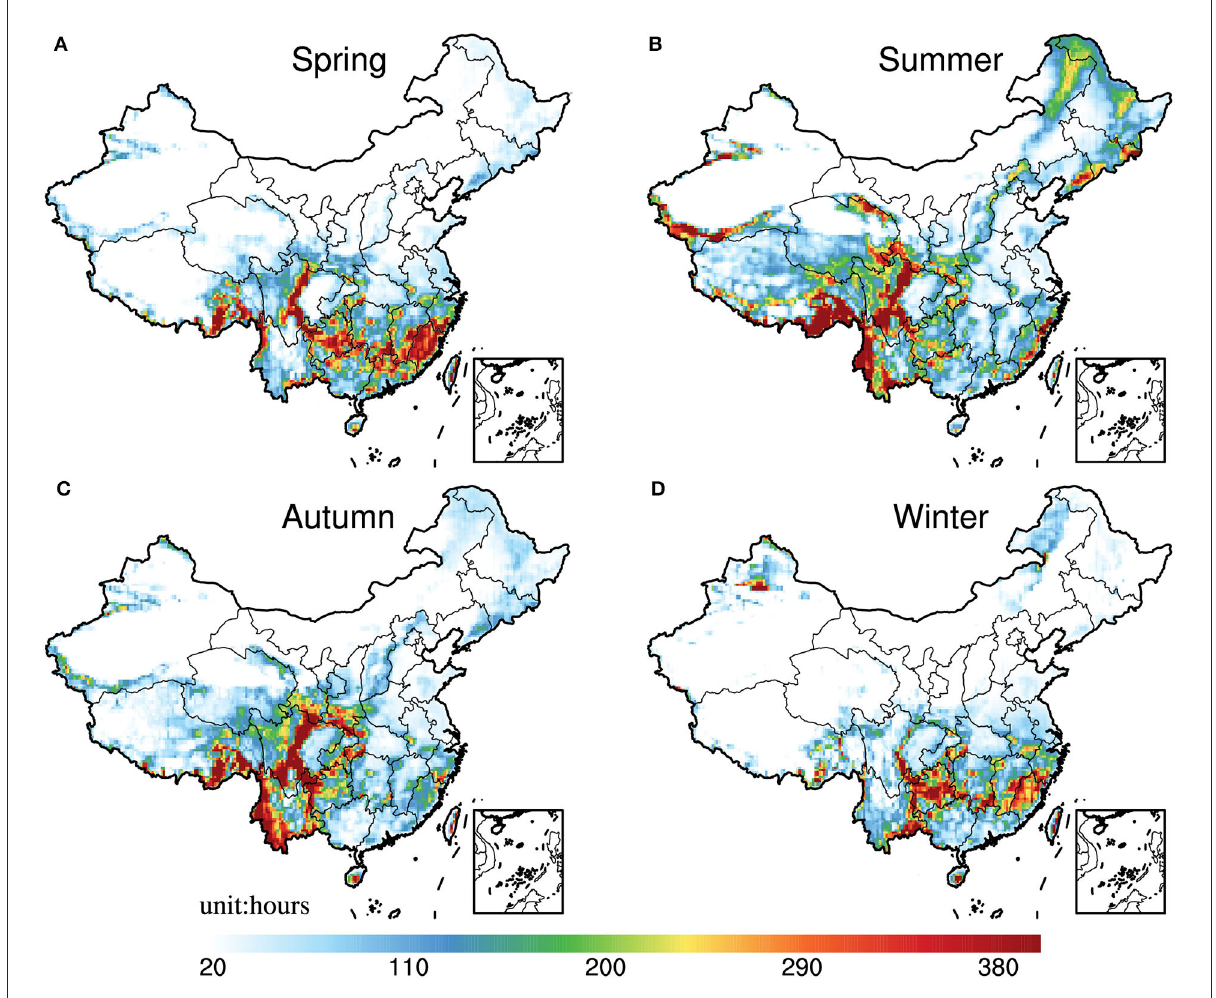
FIGURE3 (A-D) Same as Figure 2, but for seasonal mean LIMV.